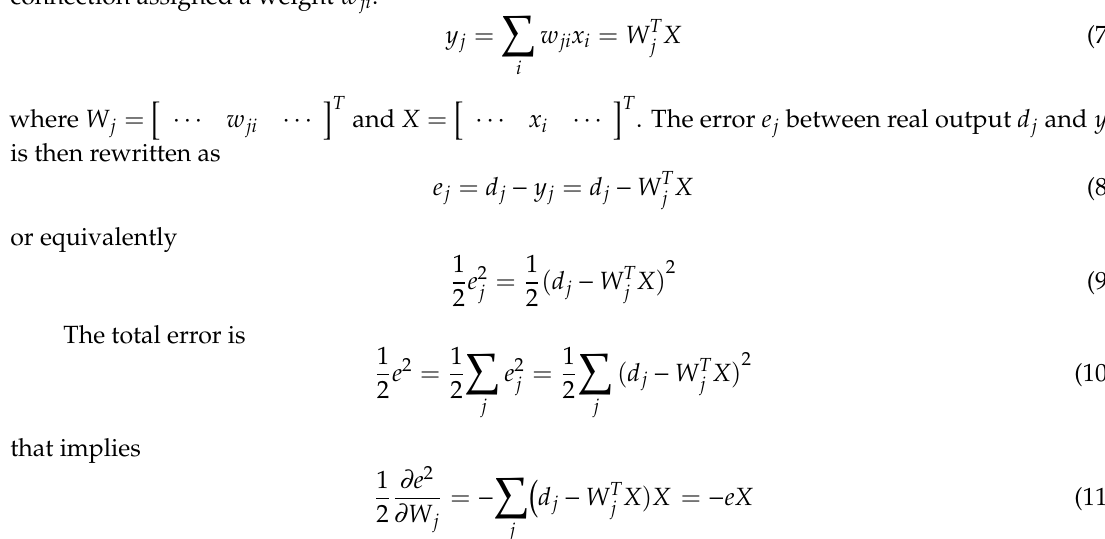
Figure 14. Network architecture of data set 2. The output of the two data sets are the respective probabilities of regions 2, 4, and 6, and because of the different input values, the input data will be normalized first. Here, the minimum and maximum normalization (min–max normalization) scale the data to the interval (0,1), and different network architectures and different excitation functions are experimented with. The final output layer uses the softmax function to normalize the output value to the (0, 1) interval, which provides a representation of the probability of the three regions. The sum is one, and the maximum value is taken as the prediction region, the loss function is cross entropy, and the learning optimization algorithm used is adam. The final prediction uses the linear formula mentioned in method 1 combined with the law of reflection to predict the final zone position of the hockey when the hockey passes the center line. 3.2.3. Control The control mechanism of initializing a stepper motor is the same used in method one. The movement after initialization will be moved according to the two prediction results. The movement based on the preliminary prediction result is called the first stage movement, and the movement based on the final prediction result is called the second stage movement.